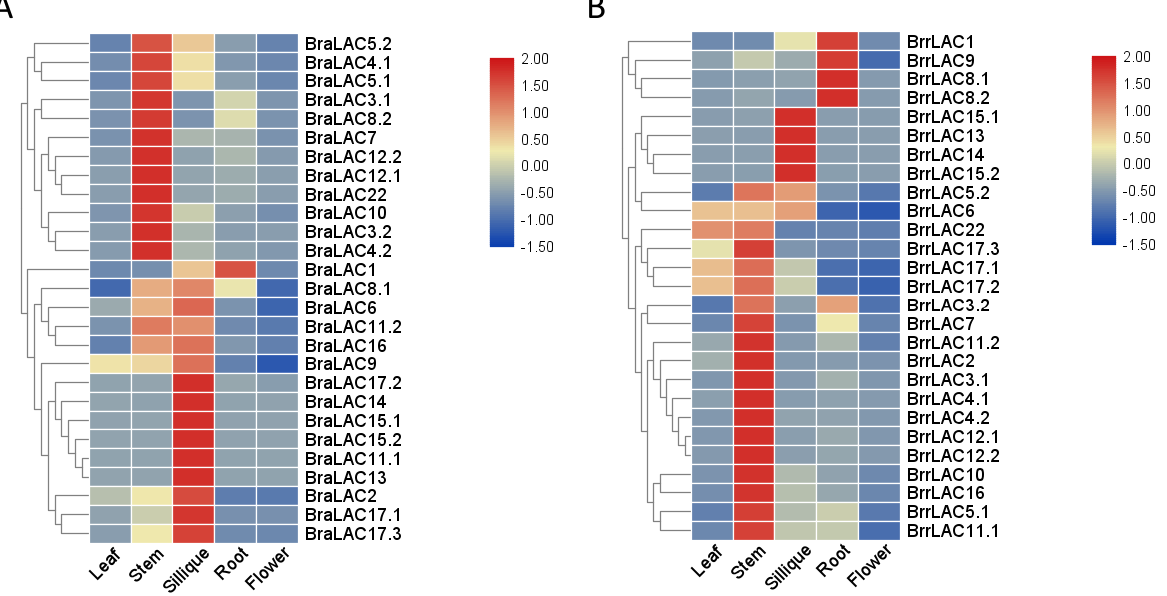
Figure 5. Transcription pattern of LAC genes across different tissues (leaf, stem, silique, root, and flower) in Chinese cabbage ( A ) and turnip ( B ) by RT-qPCR. Leaves, stems, and roots were collected from 30-day-old seedlings, while siliques and flowers were collected from bolting plants. The relative expression level was normalized using TUB gene. Values are the mean and SD of three